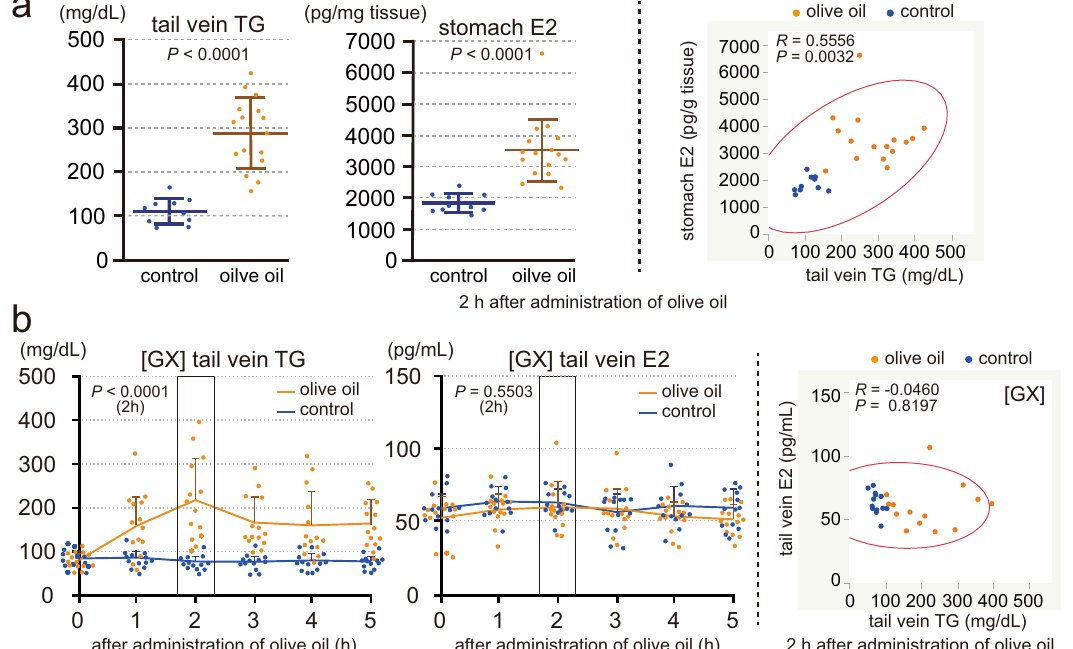
Fig. 3 Stomach secretes estrogen in response to the blood triglyceride levels in males. a Male rats (8 weeks old, deprived of food for 4 h) were orally administered olive oil (2.5 mL per kg body weight, n = 16) or control water ( n = 10). TG levels in the tail venous blood and E2 levels in the stomach tissues were measured at 2 h after the administration (left), and the correlation diagram between the blood TG and stomach E2 levels ( n = 26, right). b GX male rats (8 weeks old, operated 5 days before, deprived of food for 4 h) were orally administered olive oil (5 mL per kg body weight, n = 14) or control water ( n = 13). TG and E2 levels in the tail venous blood measured before (0) and at 1, 2, 3, 4, and 5 h after the administration (left), and the correlation diagram between the blood TG and E2 levels at 2 h after the administration ( n = 27, right). n number of rats. Data were mean ± s.d. a left and b left, P values determined by two-sided Student ’ s t -test at 2 h after the administration. a right and b right, R and P values determined by Pearson ’ s product-moment correlation with 95% density